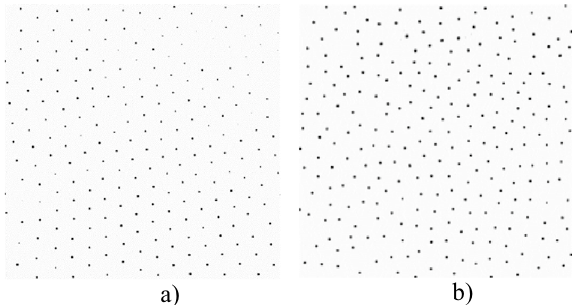
Figure 5. Single layer of the observed grain cloud at different values of laser power P las , effective coupling parameter Γ * and kinetic (effective) temperature of the grains: ( a ) Γ * = 525, P las = 40 mW, E kin = 1.38 eV; ( b ) Γ * = 31, P las = 131 mW, E kin = 26.7 eV.